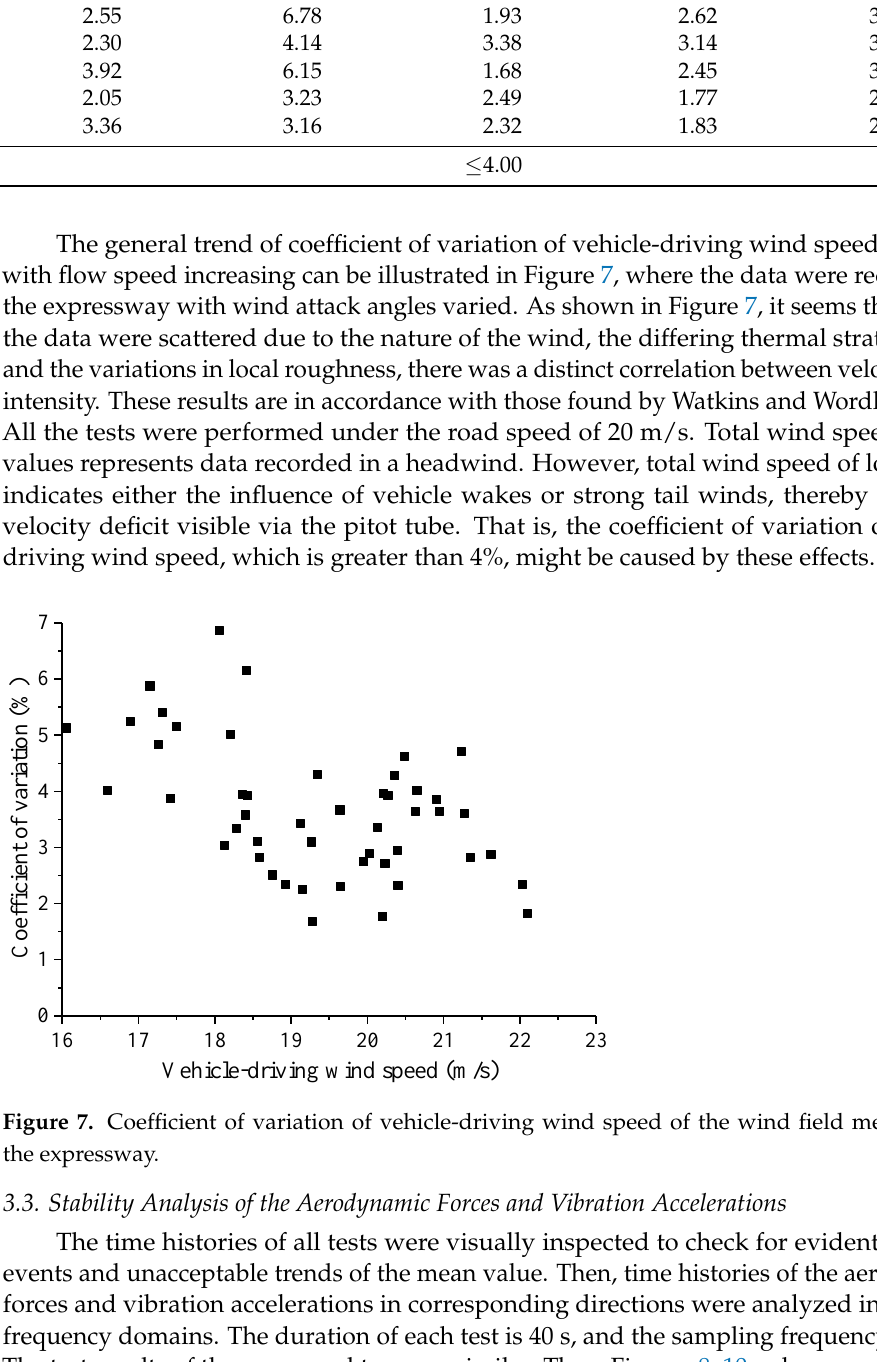
Table 4. Measured coefficient of variation of vehicle-driving wind speed (%).